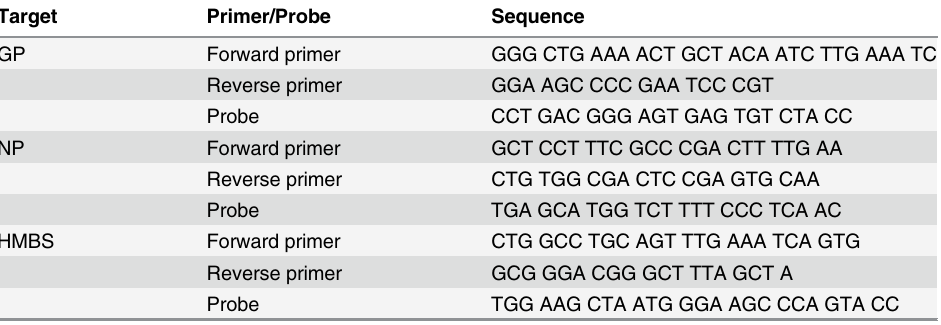
Table 1. Primer and probe sequences for the EBOV targets used in the Xpert 1 Ebola Assay.